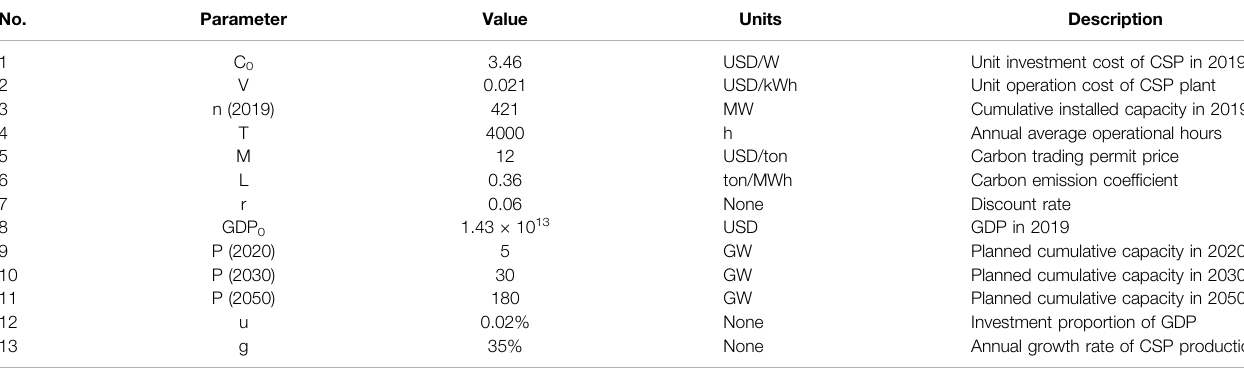
TABLE 1 | The parameters in the model. a